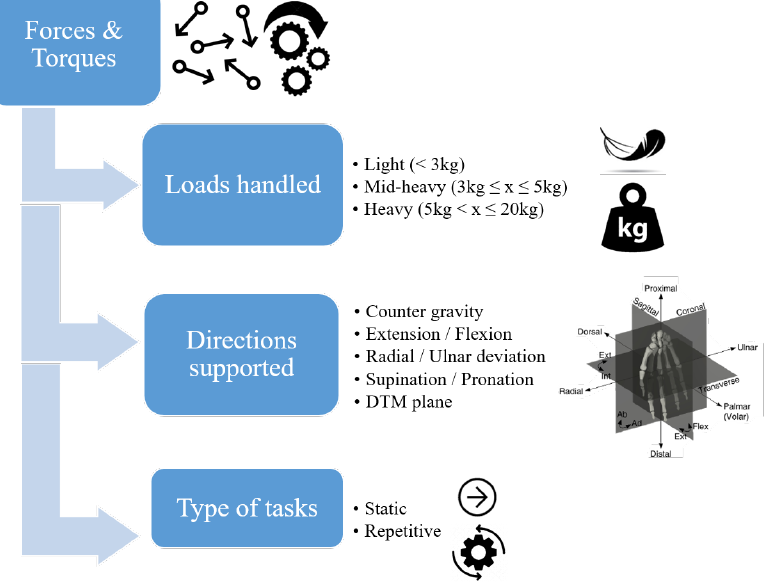
Figure 11. Force and torque requirements to be evaluated for wrist exoskeletons. For a healthy wrist, without external loads, the maximum exercisable torque in ADL is 6–10 Nm for pronation/supination, 8–14 Nm for flexion/extension [33,47], and the average estimated for radial/ulnar deviation is 1.3 Nm [48]. In general males exert larger torque than females. It has also been experimentally determined that healthy males exert naturally an average maximum grip force of 311 N (SD = 80), while females exert 192 N (SD = 47) [47]. However, the maximum prehension force required in daily activities is almost 70 N [49,50]. Note that the grip force almost changes linearly as the wrist angles change